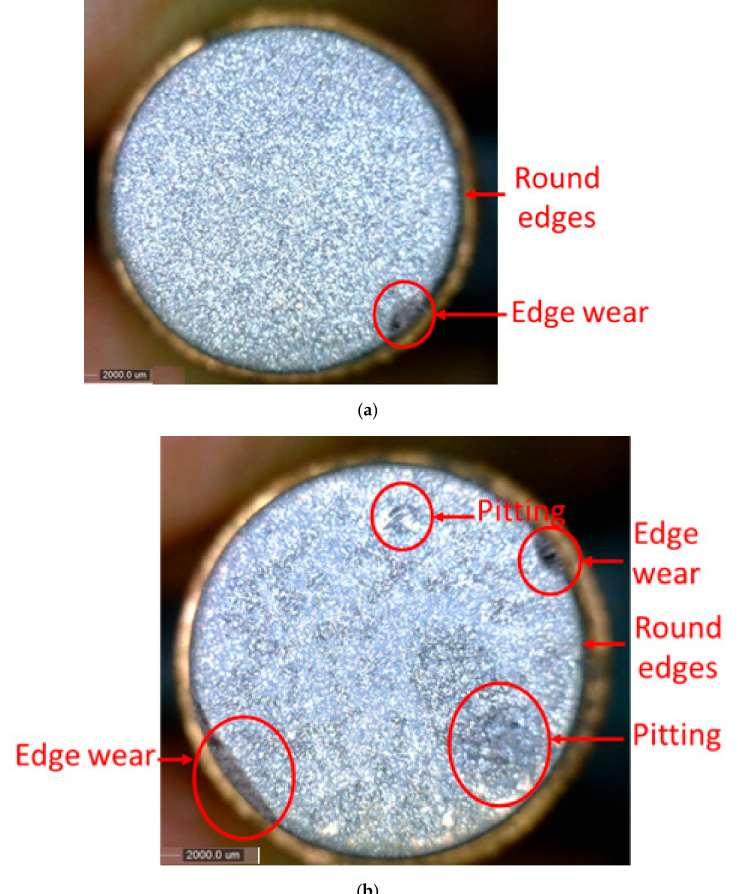
Figure 19. Variation in tool profile with I p (I p , V g , T on , T off , P) ( a ) (7,60, 300, 30, 16); ( b ) (10, 60, 300, 30, 16); units as per Table 2.